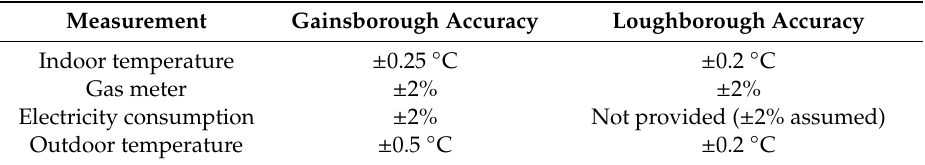
Table 2. List of measurements and provided accuracy for applying the average method.